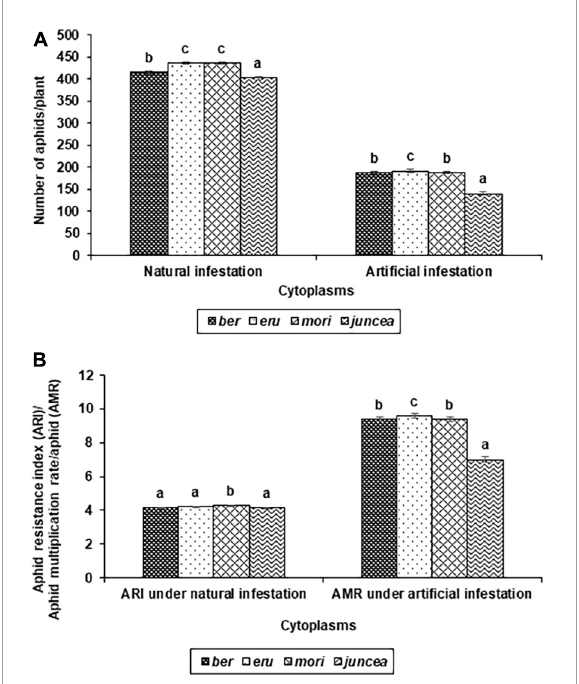
FIGURE1 Effects of cytoplasms on population build up (A) , and Resistance index and multiplication rate (B) of Lipaphis erysimi under natural and artificial infestation conditions in Brassica